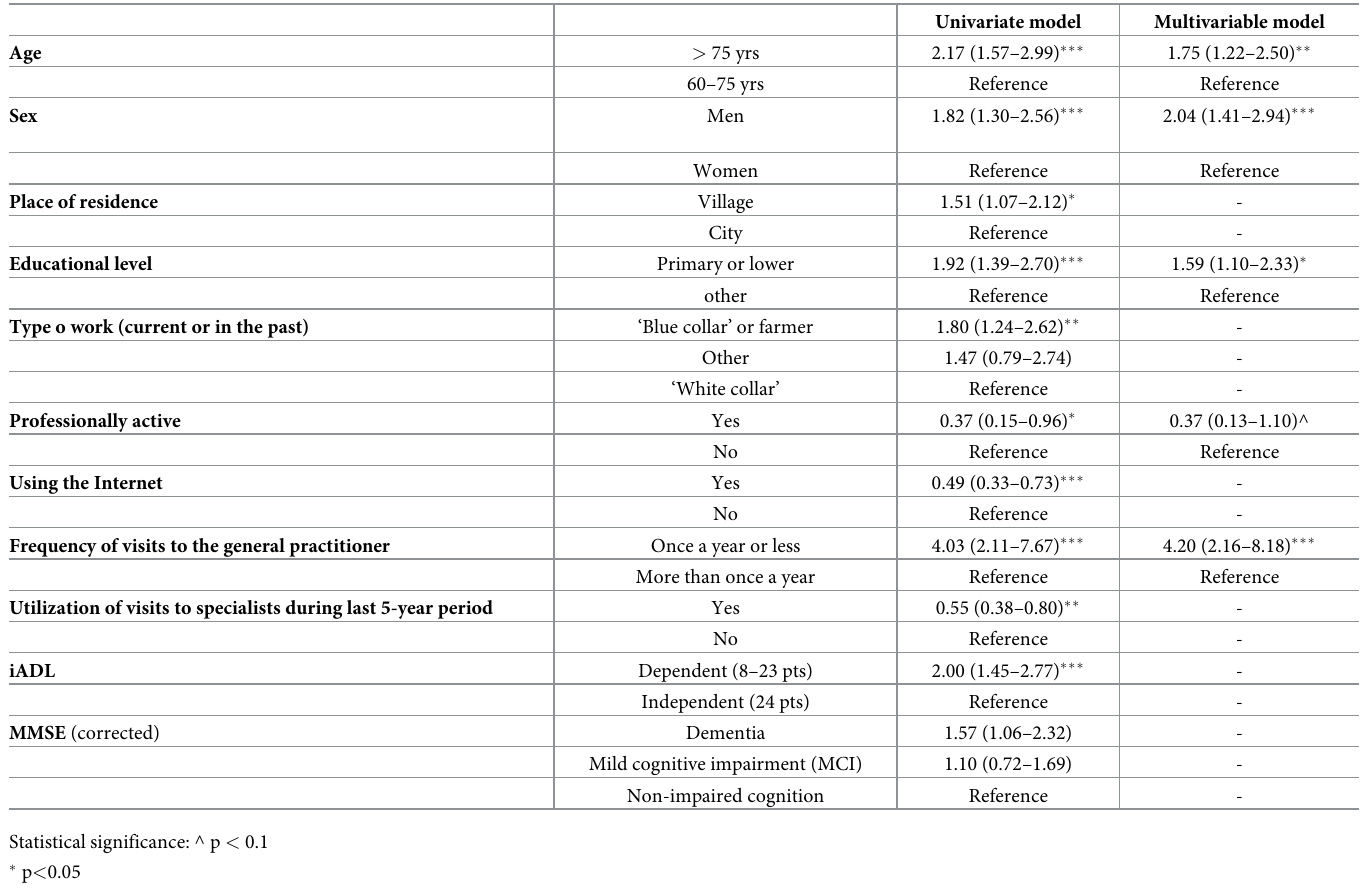
Table 2. Factors explaining the occurrence of untreated thyroid dysfunctions. There were 805 participants in the final multivariable